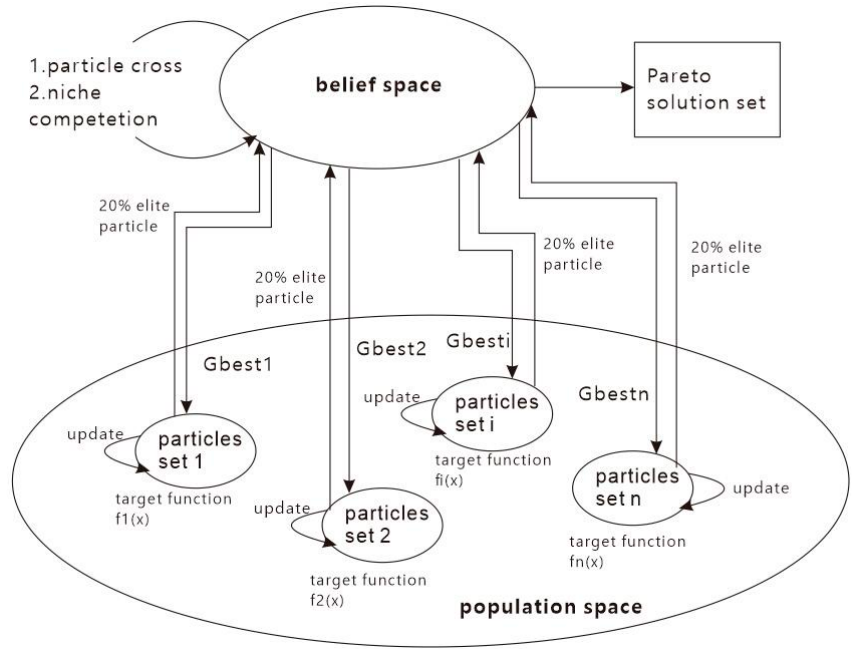
Figure 1. Schematic of the improved PSO algorithm.